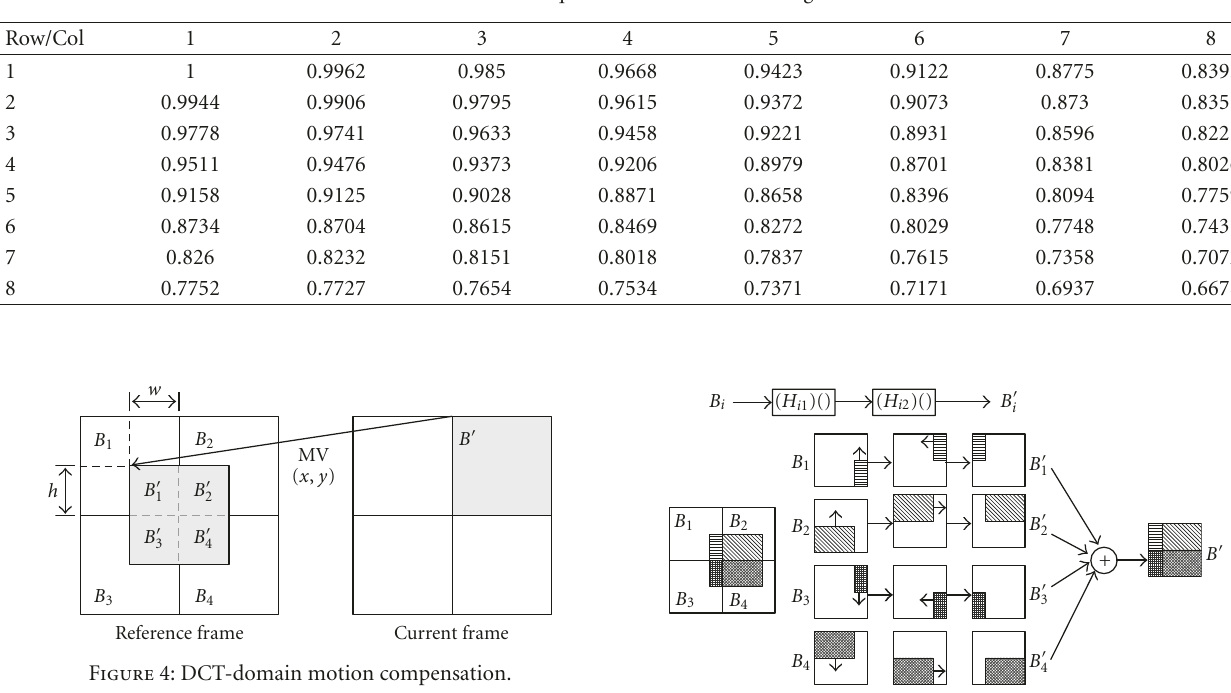
Table 1: Visual quantization matrix for images.